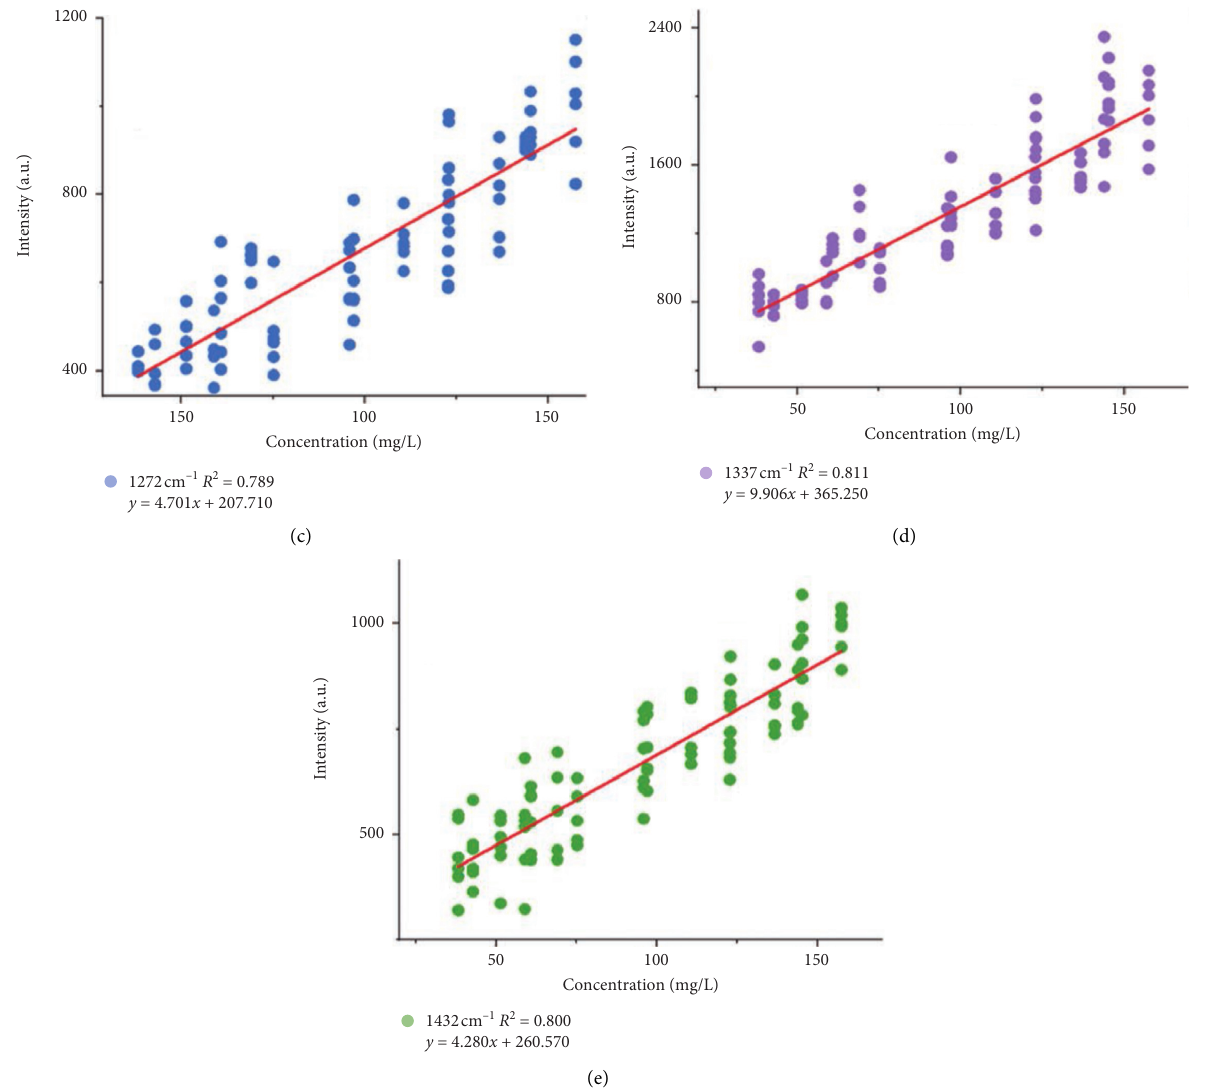
Figure 6: (a) The Raman spectra of five different concentrations of PCL in Spirulina ; (b) the linear regression equation between the sum of the three peak (1272cm − 1 , 1337cm − 1 , and 1432cm − 1 ) intensities and the PCL concentration; the linear regression equations between Raman peak intensity and PCL concentration at different Raman peaks: (c) 1272cm − 1 ; (d) 1337cm − 1 ; (e) 1432cm − 1